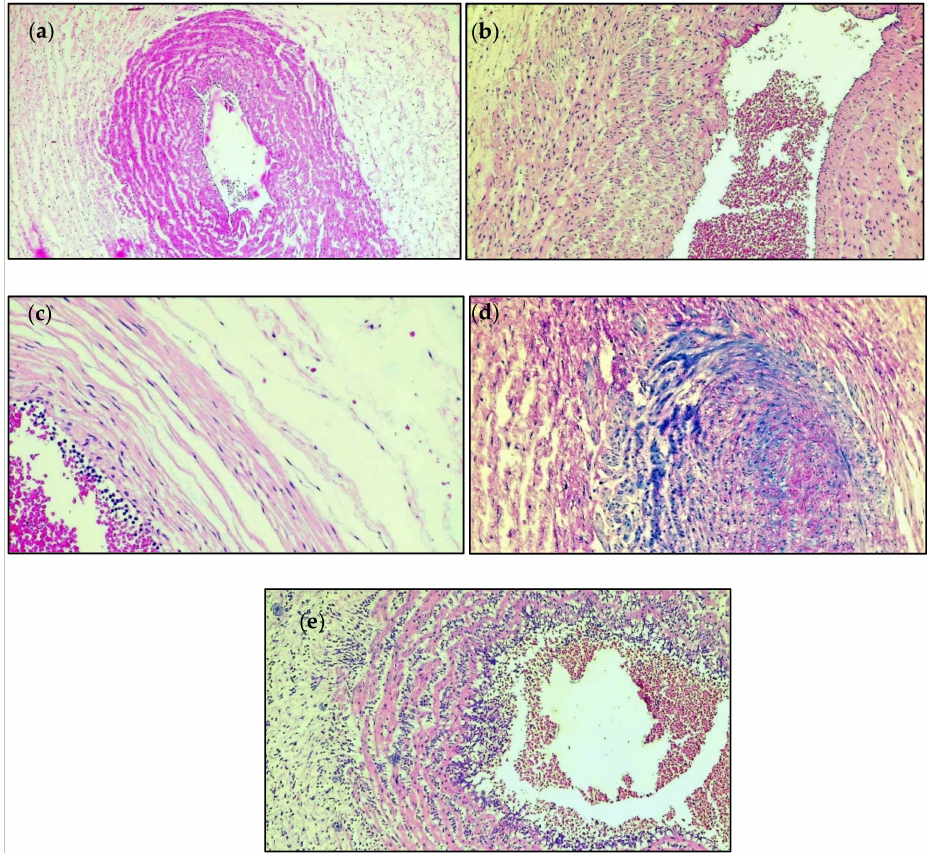
Figure 1. Histopathological findings; ( a )—Stage 0 UC inflammation; ( b )—Stage 1 UC inflammation;